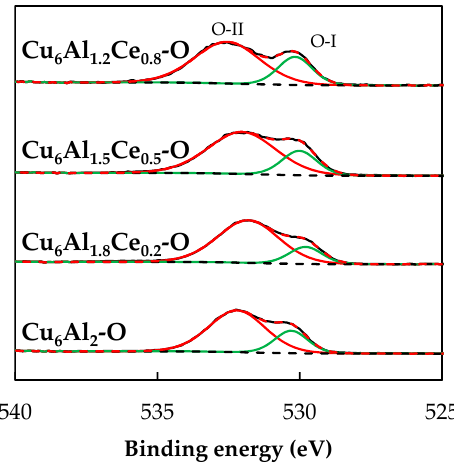
Figure 8. O 1s photopeaks of Cu 6 Al 2 − x Ce x -O samples.